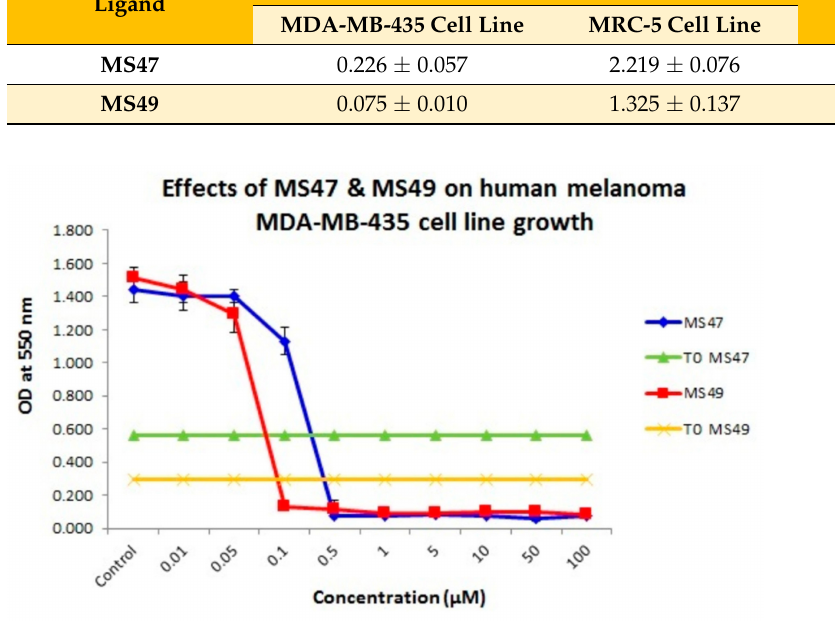
Figure 4. Dose–response curves that show the growth inhibiting effects of MS47 and MS49 against melanoma MDA-MB-435 cell line. Values are mean ± SD, n = 8, graphs are representative of experiments performed on at least three separate